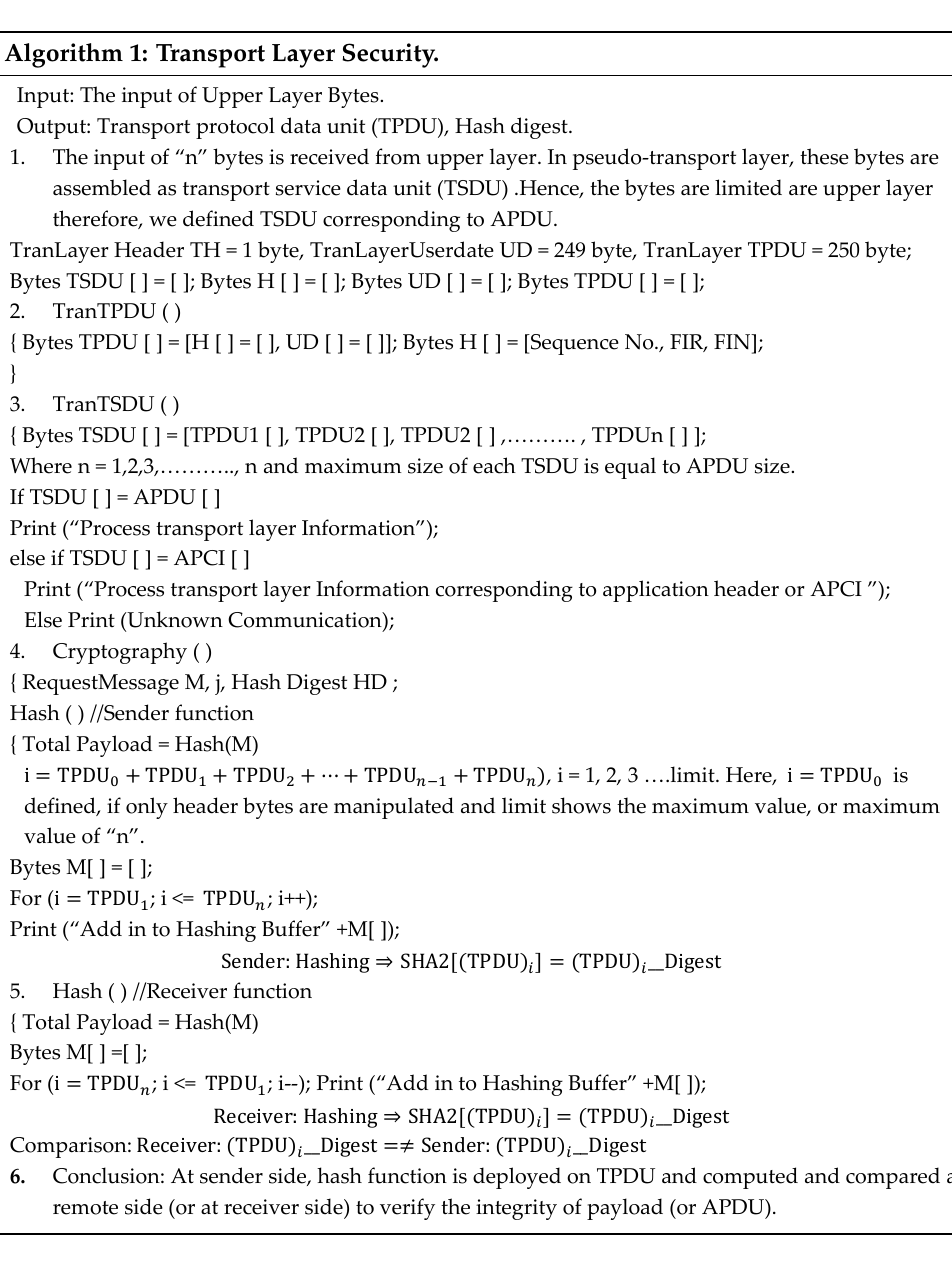
6. Algorithm: Pseudo Code Transport Layer Message Construction with Security Design Algorithm 1: Transport Layer Security.